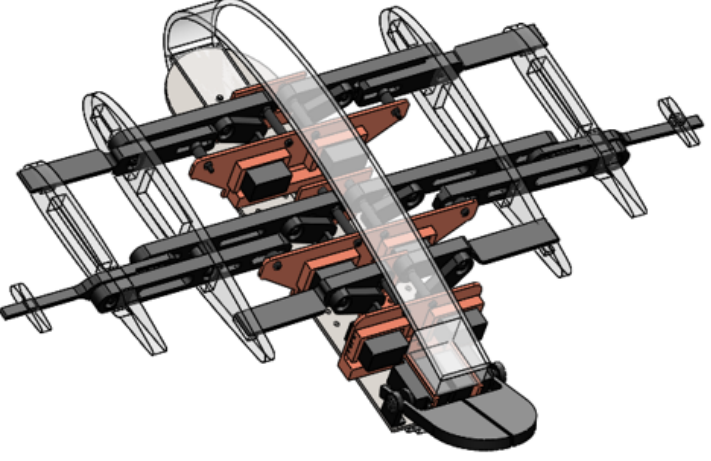
Figure 9. CAD model of the assembly of the